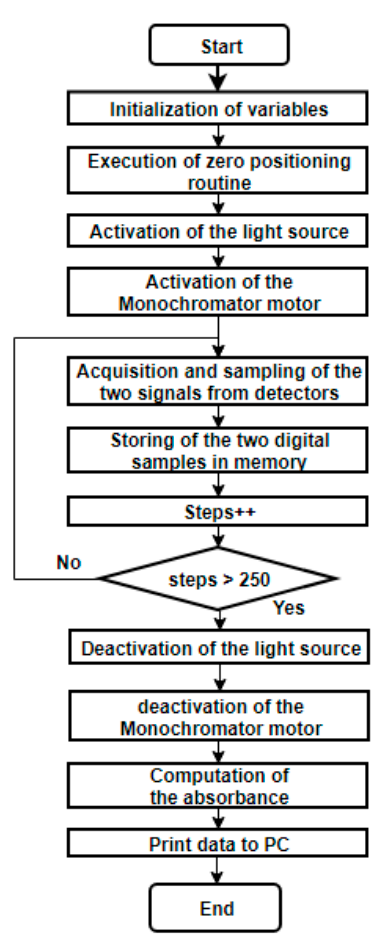
Figure 4. Flowchart of the microcontroller algorithm.